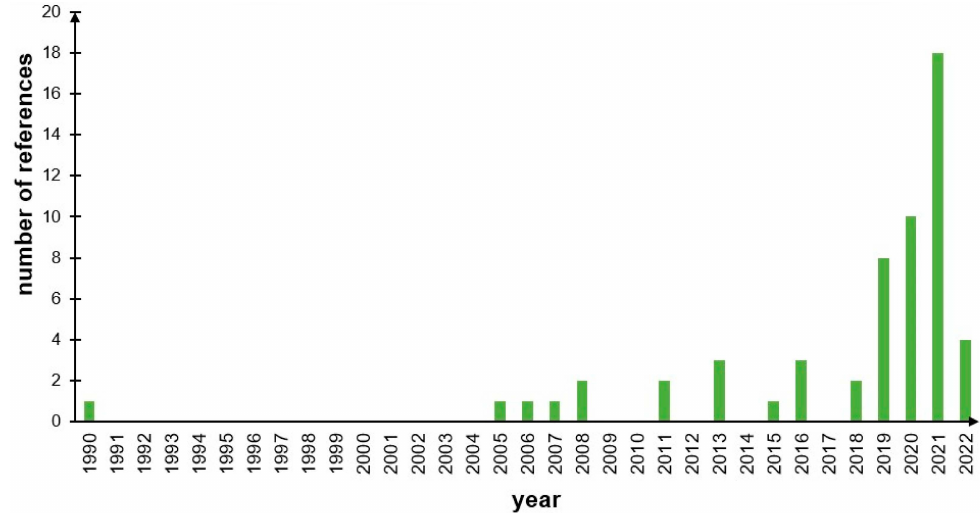
Figure 1. Histogram of publications of satellite-derived SOC studies according to